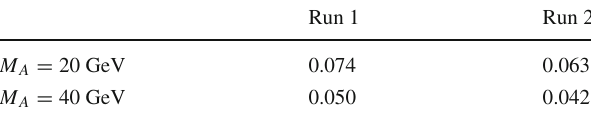
Table 3 Efficiencies of R → V S signals for the W Z selection in ATLAS hadronic diboson searches